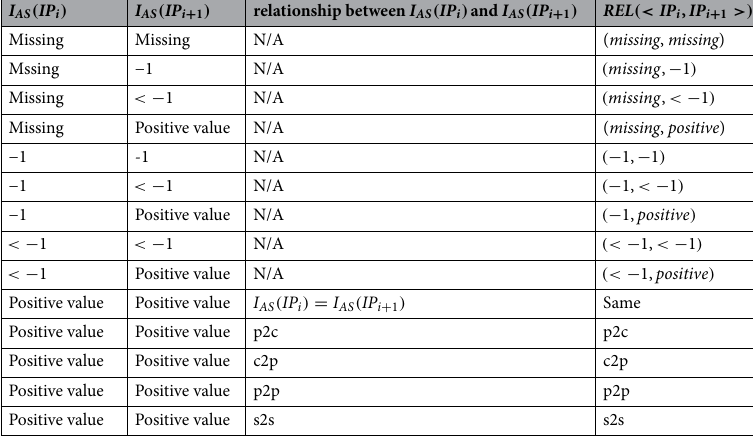
Table 3. Values of REL (< IP i , IP i + 1 >)